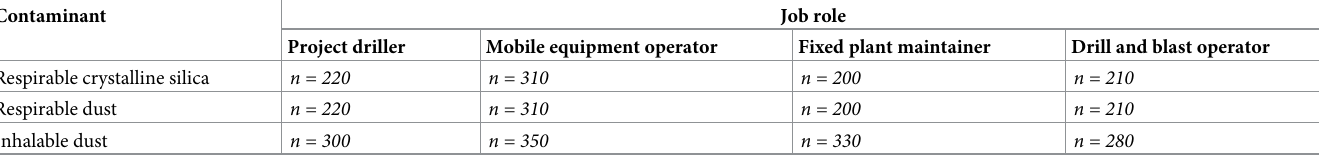
Table 1. Personal samples (measured data) collected by contaminant for each job